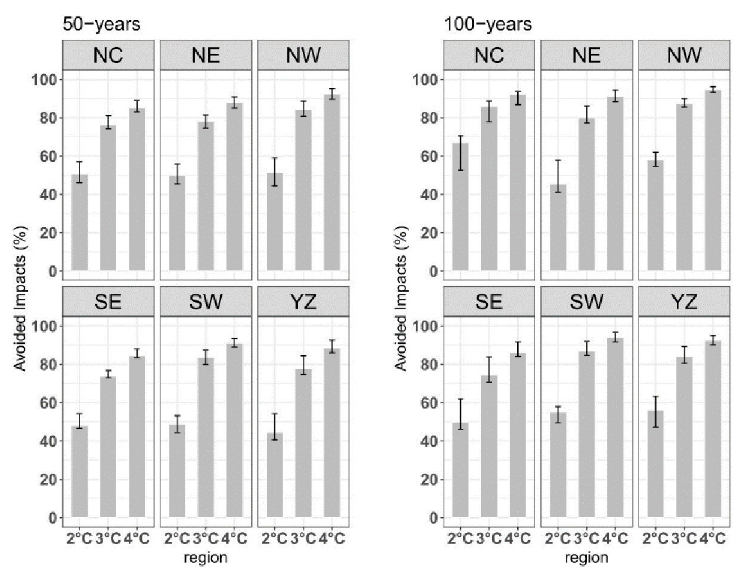
Fig 8. The avoided risk of extreme precipitation events with 50-year and 100-year return period over the six subregions of China at 1.5˚C warming compared with warmer future scenario (units: %). The black vertical lines over the bars show the 95% confidence